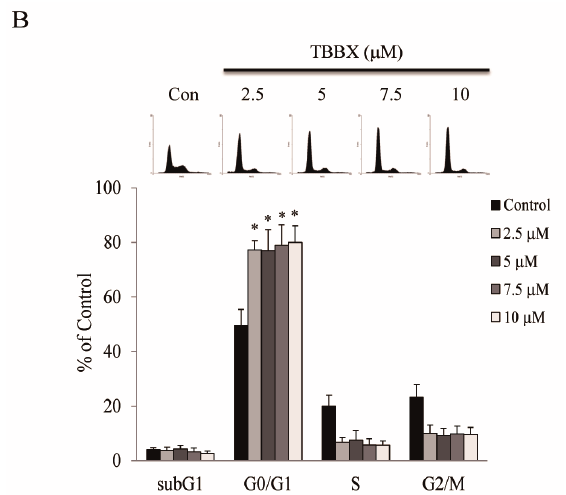
Figure 2. The growth inhibition effect of TBBX in H1299 lung cancer cells. ( A ) A549, H1299, H460 and H1155 cells were incubated with a serial dosage (0, 2.5, 5, 7.5, 10 and 20 μ M) of TBBX or suberoylanilide hydroxamic acid (SAHA) for 24 h. Afterward, MTT assay was performed for cell viability as described in Materials and Methods. Data shown are representative of at least three independent experiments. ( B ) H1299 cells were seeded in a 10 cm petri dish for 24 h. Cells were then treated with various doses of TBBX for 24 h. After cells were harvested, flow cytomertic analysis was performed for cell cycle distribution. Data were the mean ± S.D. of triplicate samples. Significant difference was observed from the control group (* p < 0.05).